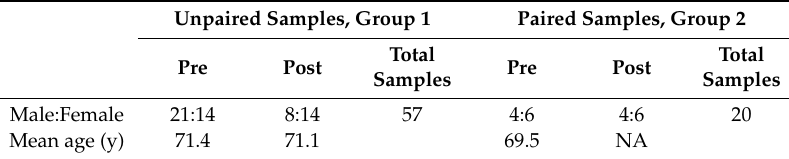
Table 1. Summary of age and sex of donors in the two groups.